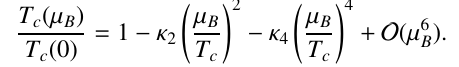
Figure 1. (Ref. [11]) Extrapolation of the half width of the transition to finite baryon chemical potential as defined in equation (3). The insert shows the chiral suceptibility χ as a function of the chiral condensate region illustrates